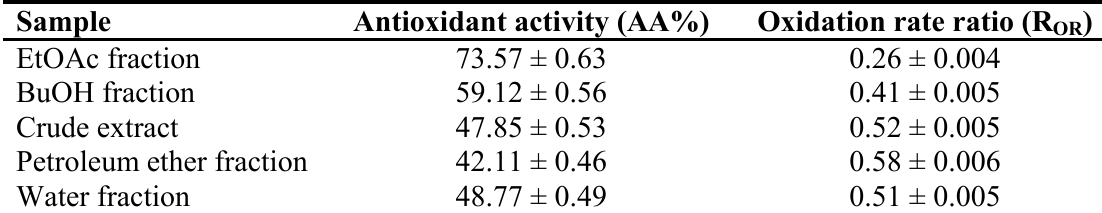
Table 1. Antioxidant activities of crude extract and its derived fractions of C. sinica flowers assayed by β -carotene bleaching method. Final concentration was 5 μ g/mL. All the AA% and R values were calculated at t = 120 min. Values of each data were OR means ± SD ( n = 3). P <